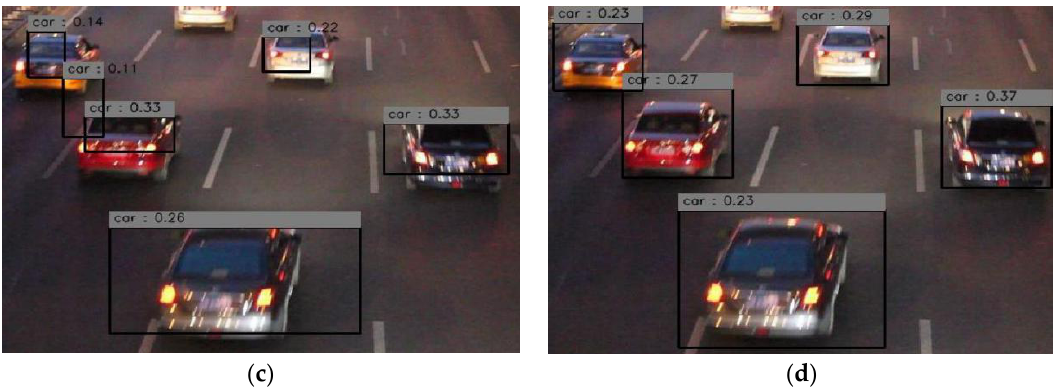
Figure 5. Multi-scenario vehicle monitoring ( a ) YOLO cloudy day vehicle monitoring, ( b ) YOLO-UA cloudy day vehicle monitoring, ( c ) YOLO night vehicle monitoring, and ( d ) YOLO-UA night vehicle monitoring.